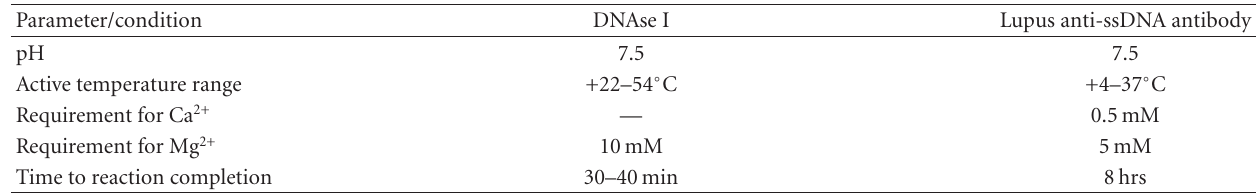
Table 1: Summarized comparison of DNAse I (from bovine pancreas, Ambion) and lupus anti-ssDNA antibody hydrolysis reactions. Parameter/condition DNAse I Lupus anti-ssDNA antibody pH 7.5 7.5 Active temperature range +22–54 ◦ C +4–37 ◦ C Requirement for Ca 2+ — 0.5 mM Requirement for Mg 2+ 10mM 5mM Time to reaction completion 30–40 min